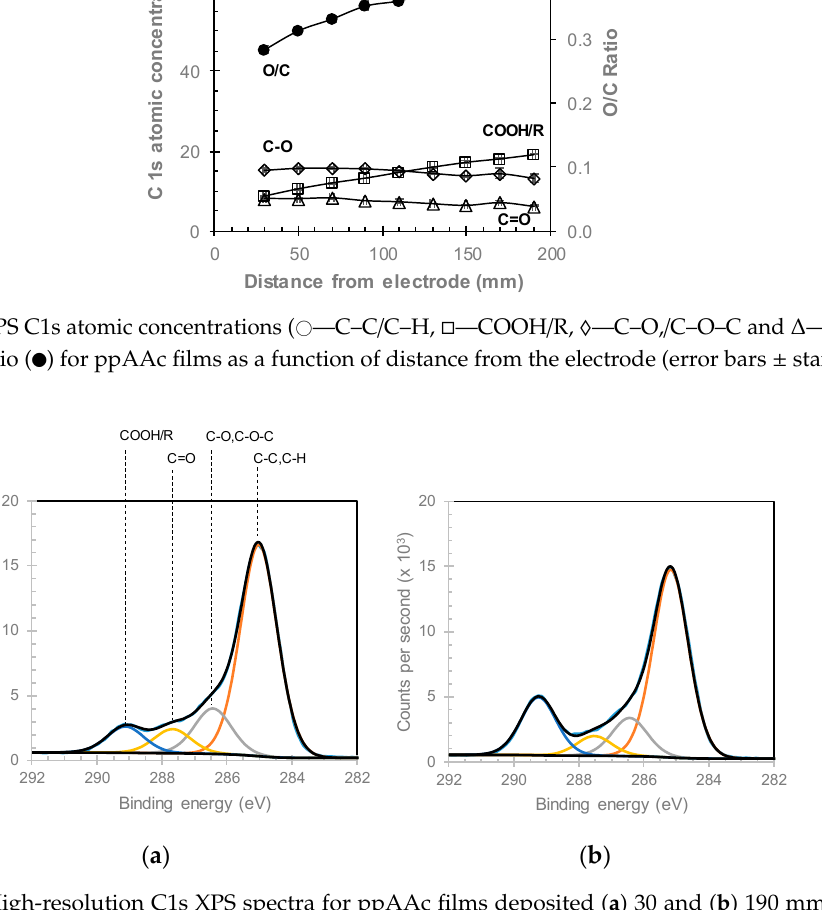
Figure 4. High-resolution C1s XPS spectra for ppAAc films deposited ( a ) 30 and ( b ) 190 mm from the electrode.